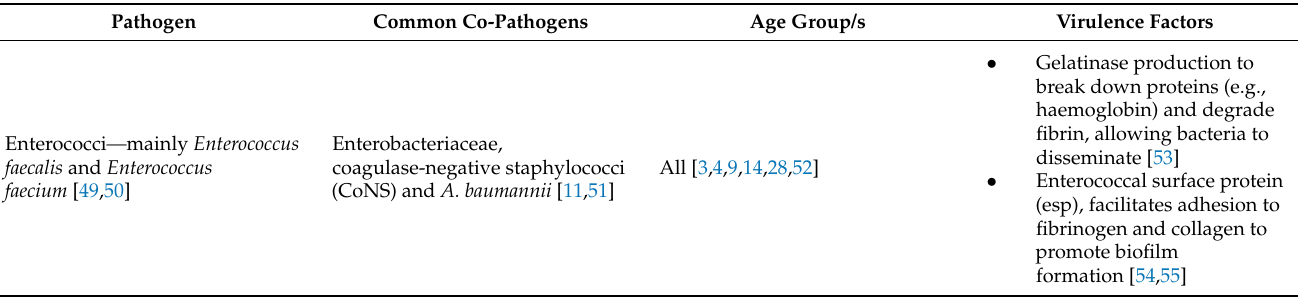
Table 3. Bacterial species that are commonly implicated in polymicrobial